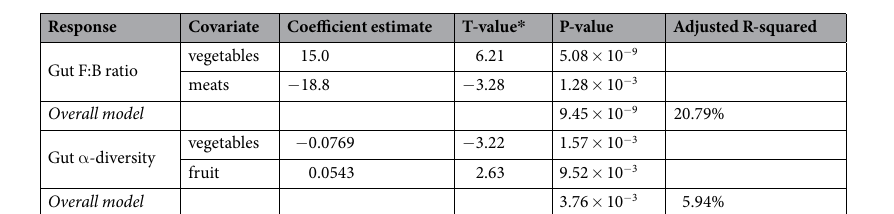
Table 2. Associations detected in multiple linear regressions for children’s gut microbiotas’ Firmicutes-to- Bacteroidetes ratio and α -diversity. Each multiple regression comprised 17 potential covariates, but only diet- related ones were retained by variable selection procedures. Coefficient estimates and significance (p-values) are shown, together with overall model significance and R-squared, for the regressions restricted to the selected diet-related covariates. * Test statistic of a null hypothesis that a covariate’s coefficient is equal to